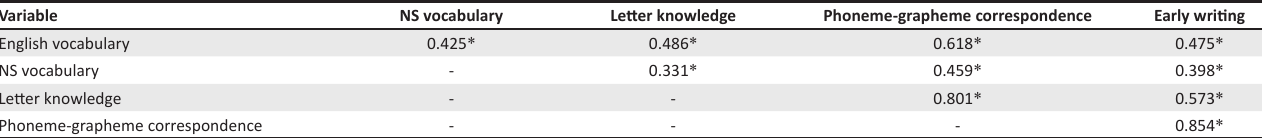
TABLE 2: R- values of Pearson correlations between English receptive vocabulary , Northern-Sotho receptive vocabulary , Letter knowledge , Phoneme-grapheme correspondences and Early writing. Variable NS vocabulary Letter knowledge Phoneme-grapheme correspondence